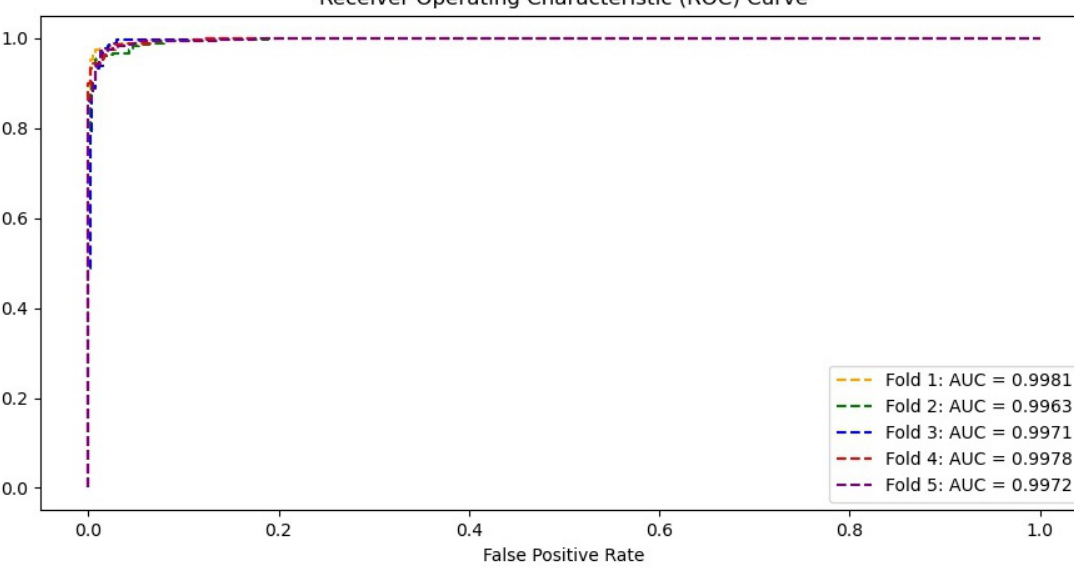
Figure 9. Receiver operating characteristic (ROC) curves for the Residual-Shuffle-Net with its respective area under the curve